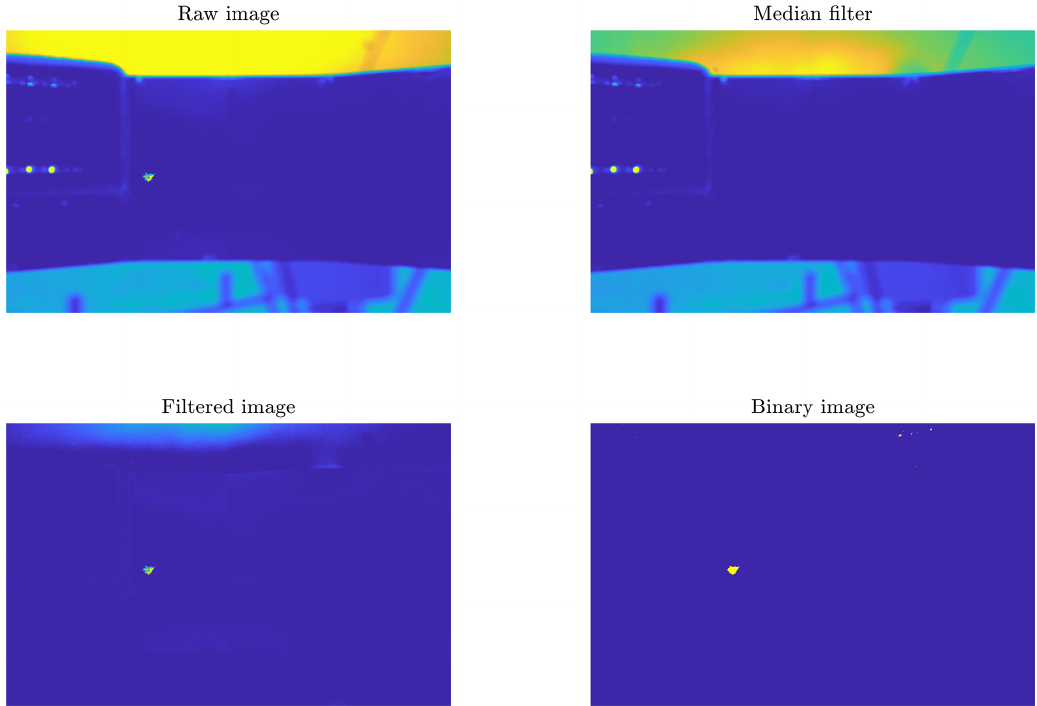
Figure B1. Raw image, median filter, filtered image and final binary image for an example where the median filter does not perform well due to changes in sky luminosity. Some artifacts appear on the top right of the binary image